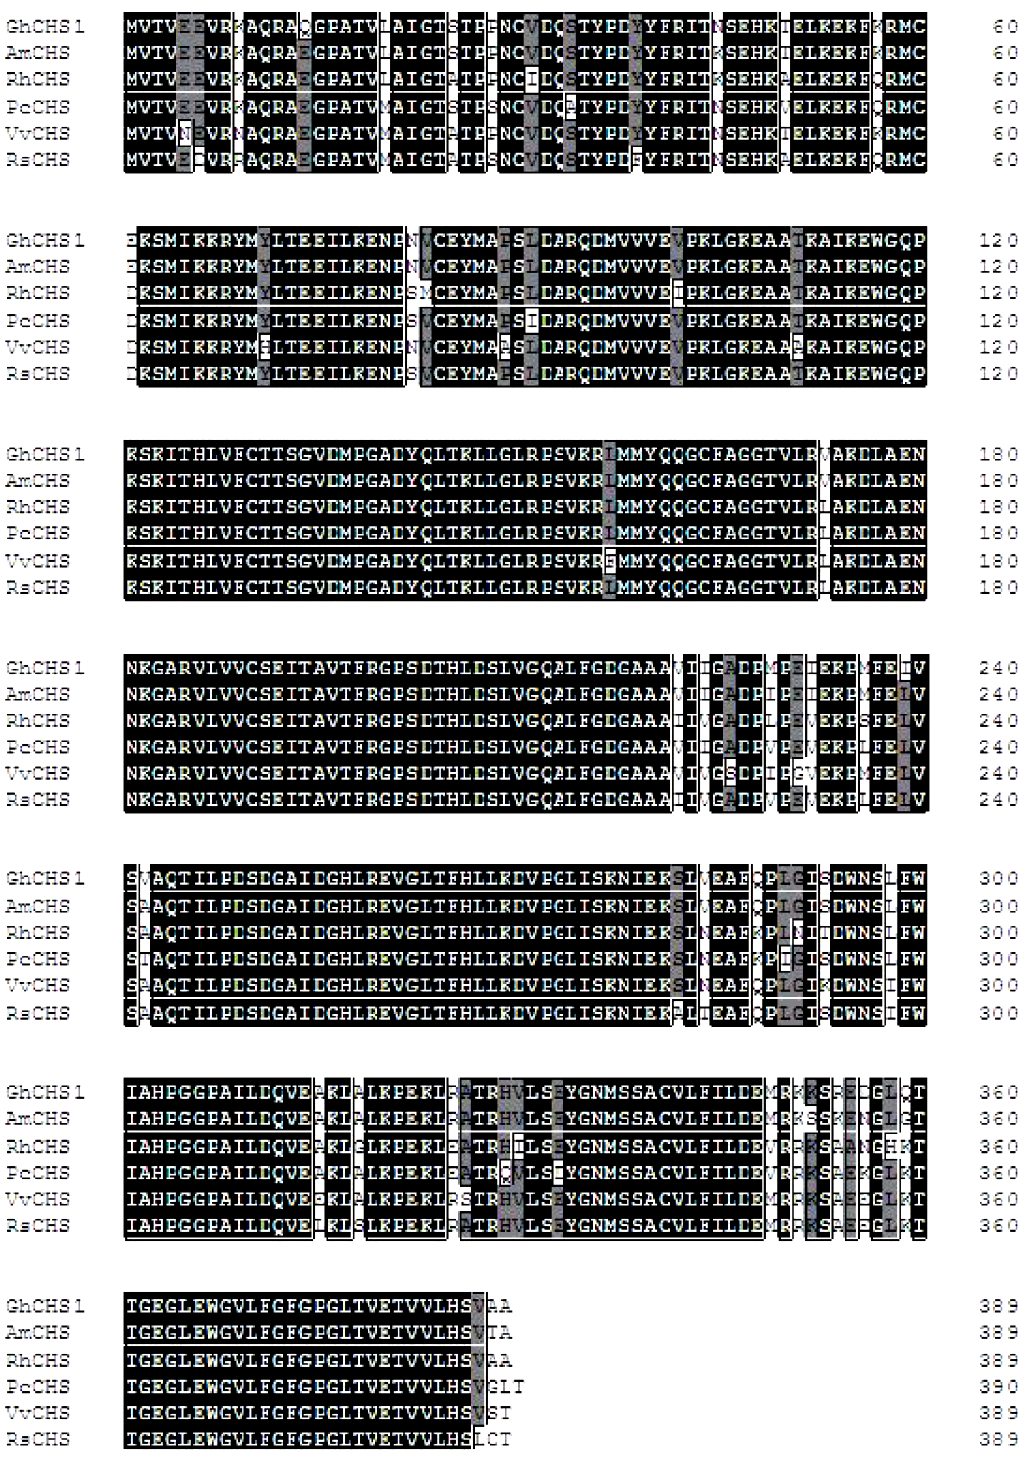
Figure 2. Multiple alignment of deduced amino acid sequences of plant chalcone synthase. Abbreviations of sequences RhCHS: Rosa hybrid cultivar ’Kardinal’ (BAC66467); PcCHS: Pyrus communis (AAX16494); VvCHS:Vitis vinifera (BAB84111); AmCHS: Abelmoschus maniho- t(ACE60221); RsCHS: Rhododendron simsii (CAC88858).